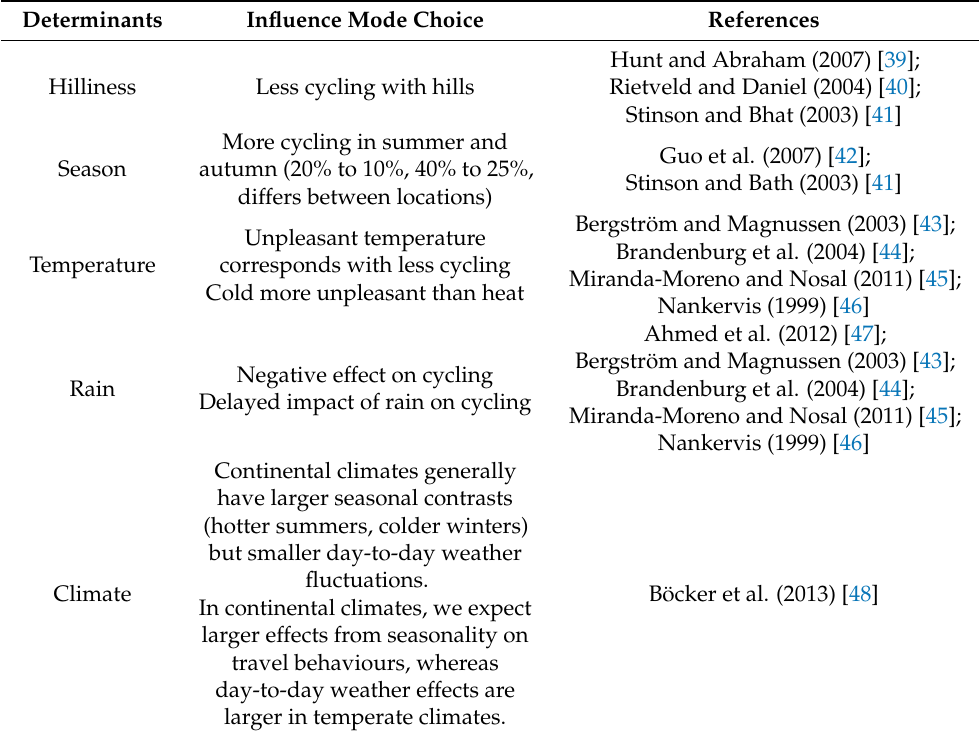
Table 1. Environmental factors and their impact on